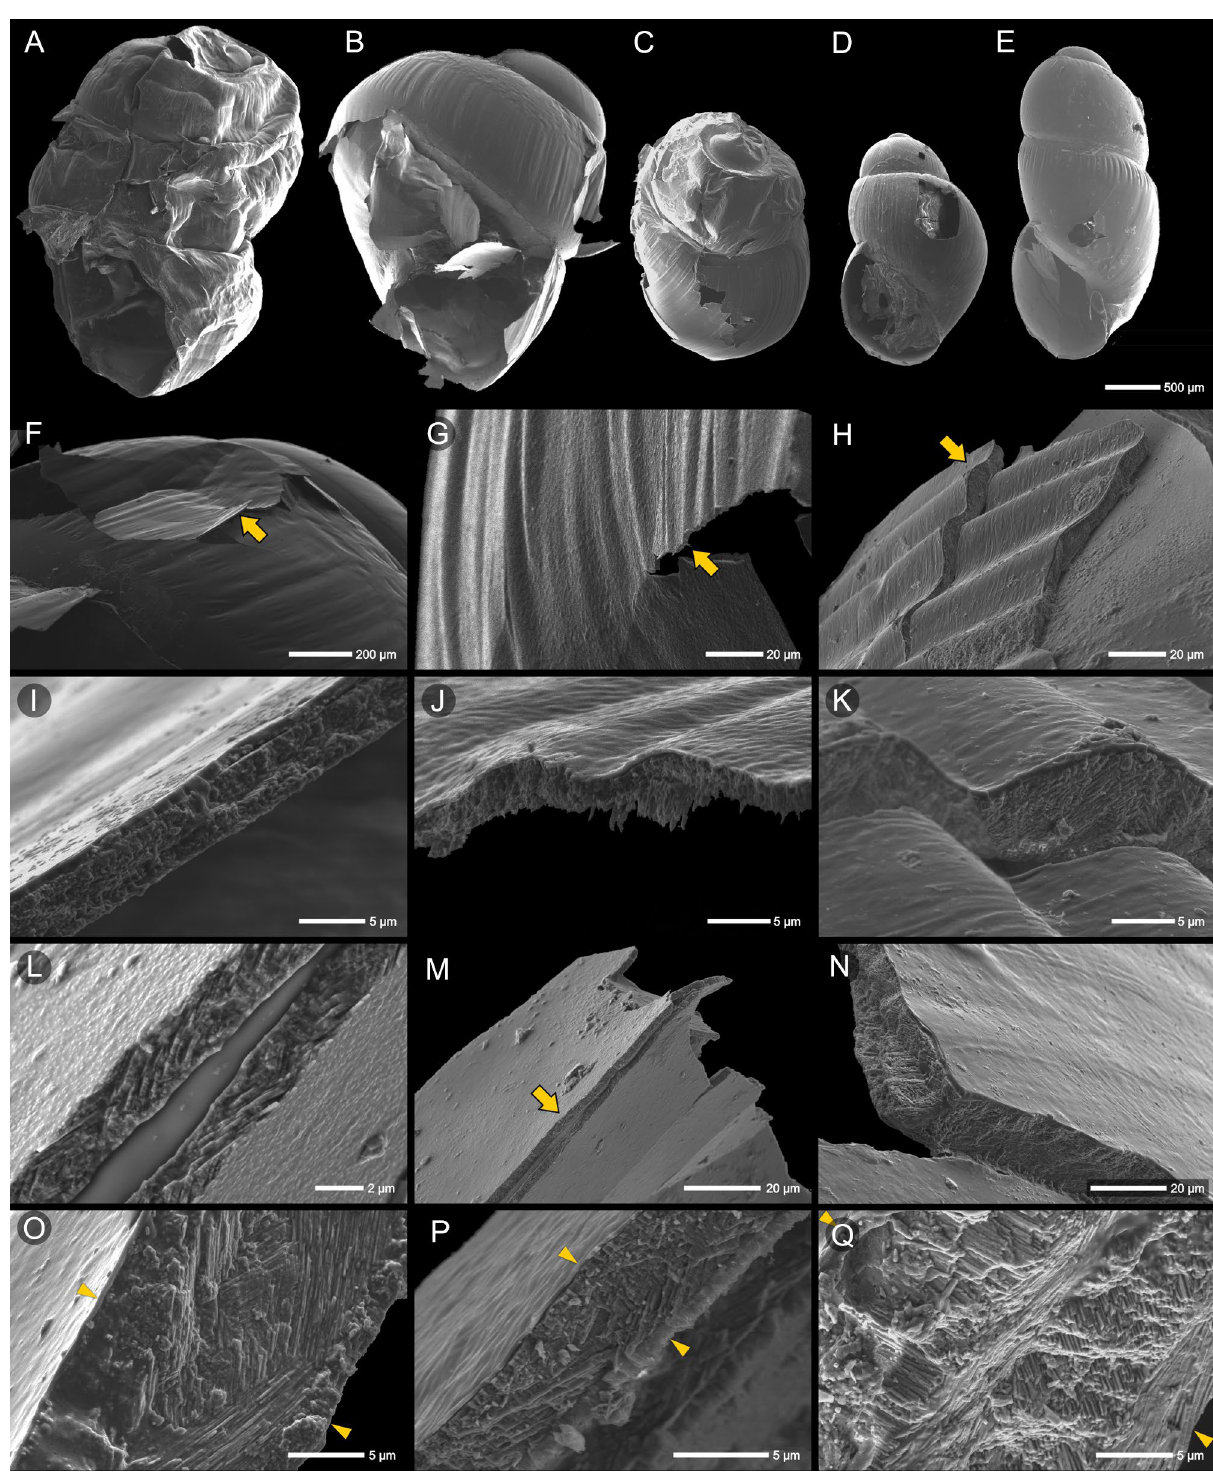
Figure 6. Neonates of O. miranda ( A,B,F,I,L,M,O ) and Z. ventriosa ( C,G,J,P ) in direct comparison with hard-shelled embryos and neonates of R. variegata ( D,N,Q ) and S. addisoni ( E,H,K ); SEM microphotographs. The vacuum conditions in SEM led to the shrinkage of the thin O. miranda shell ( A ); freeze-drying of ‘soft-shelled’ neonates prior to SEM imaging reduced the level of deformity ( B,C ). Contrastingly, R. variegata and S. addisoni shells do not require special preparation and retain their shape ( D,E ). ( F ) The dented surface of O. miranda neonate and SEM-close-up ( I ) on a cross-section of the shell just a few micrometers thick (arrow in F indicates the region enlarged in I ). ( G,J ) Shell of Z. ventriosa in comparison with similarly ornamented fragment of S. addisoni ( H,K ); note several times thicker shell in the latter (arrows in G,H indicate the regions enlarged in J,K , respectively). ( L,M ) Inner surface of intact periostracum which still connects two fragments of broken aragonite shell of O. miranda (the arrow in M indicates the region enlarged in L ); note the difference between shell thickness in O. miranda ( L,M ) and R. variegata ( N ). All observed specimens have similar crossed-lamellar microstructure ( L–Q ). However, just as shell thickness, also the number of lamellar layers of alternate orientation within the shell differs ( L,M,O,P vs N,Q